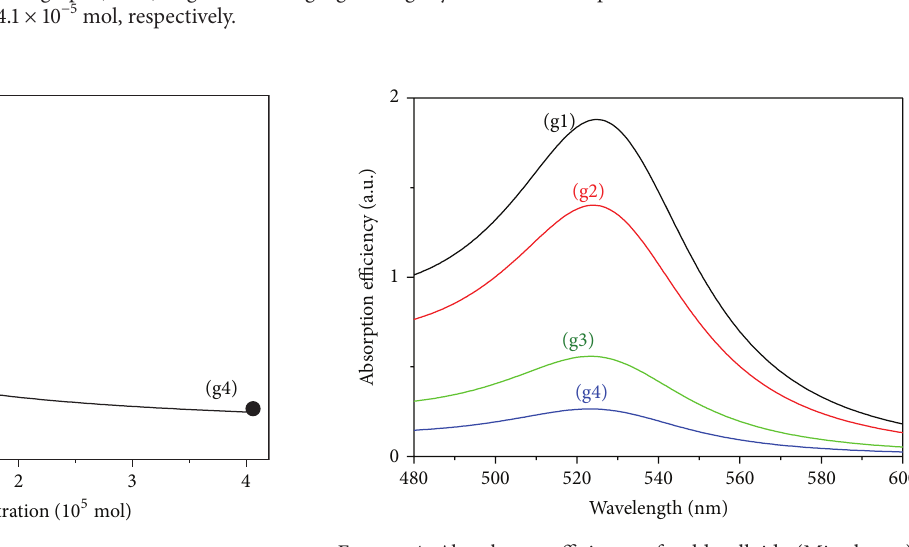
Figure 4: Absorbance efficiency of gold colloids (Mie theory) at different GNP size where the different curves (g1–g4) correspond, respectively, to 26.6, 21.1, 7.8, and 4.2 nm. smaller than 2 nm, the LSPR diminishes completely as the energy levels for the electrons become discrete and instead step-like spectral transitions occur